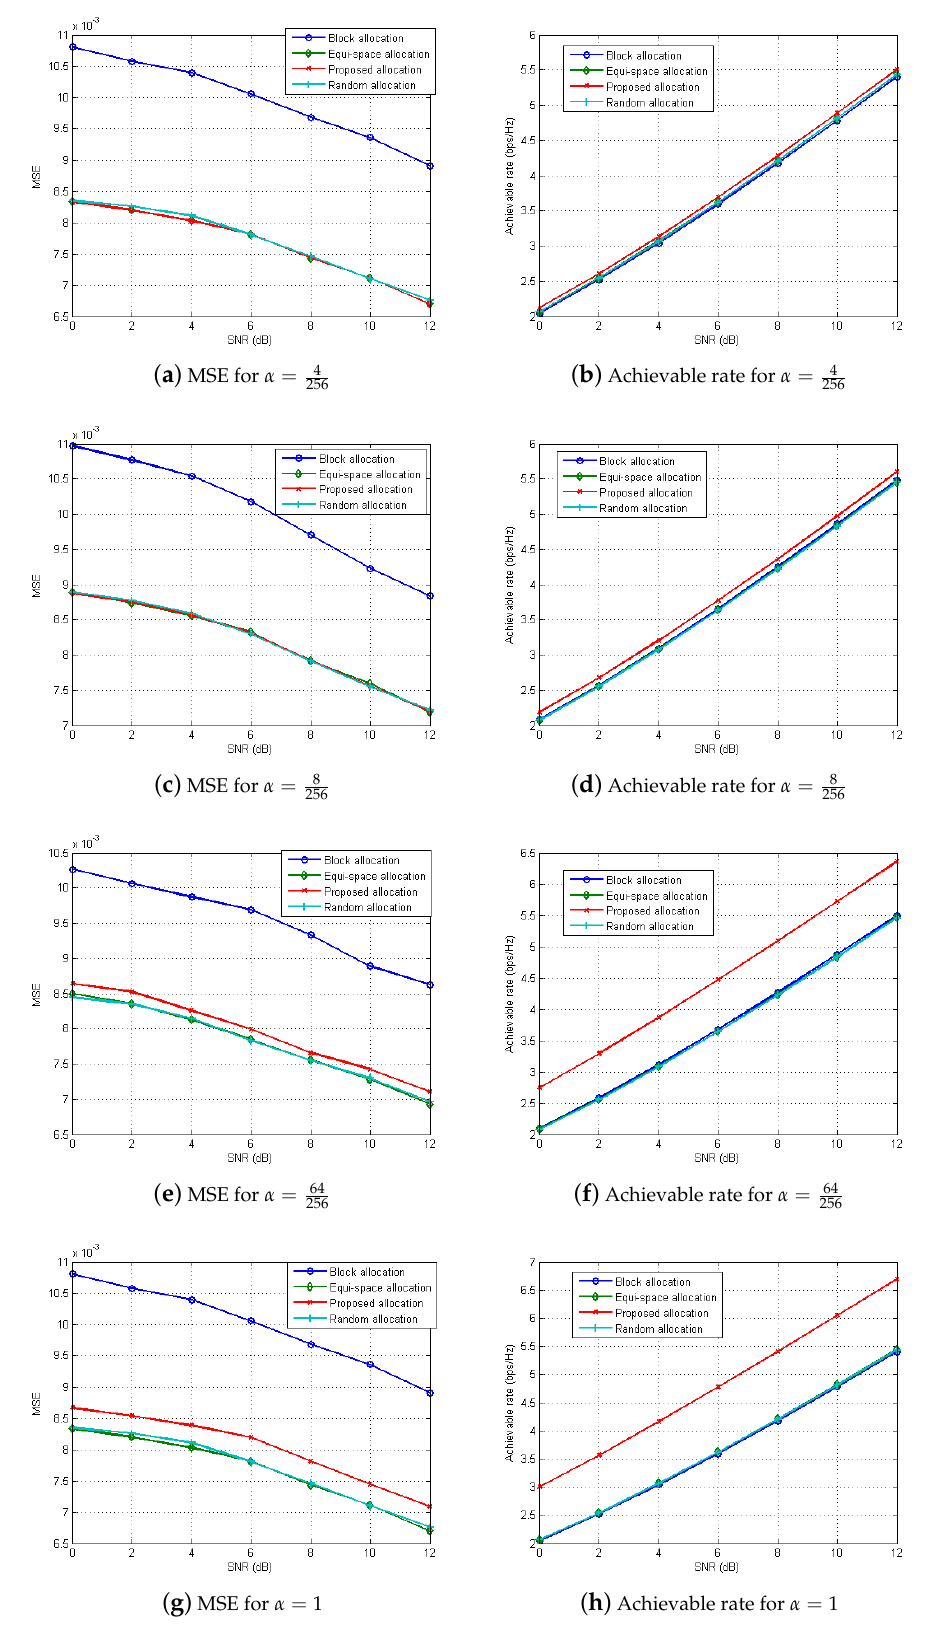
Figure 6. Mean square error (MSE) ( left ) and Achievable rate ( right ) for different subcarrier alloca- tion